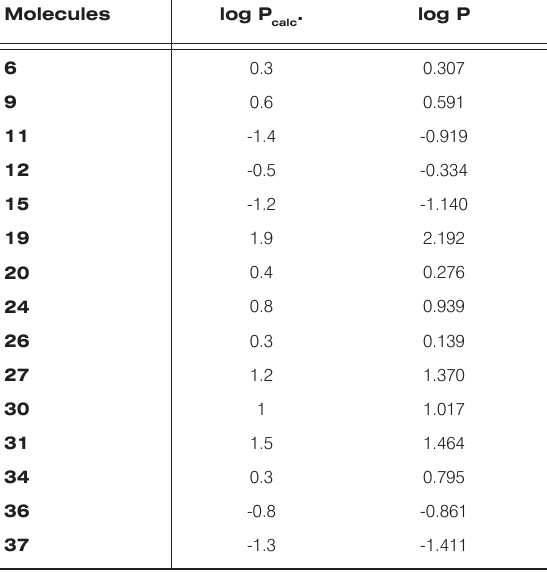
Table 13. Calculated values of log P by similarity clusters for the molecules in the test set. Molecules log P . calc